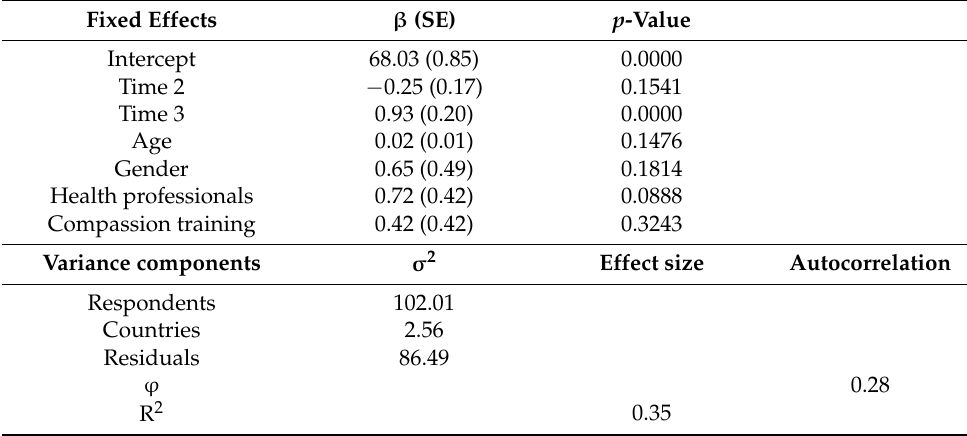
Table 1. Estimates of the final model for self-compassion.